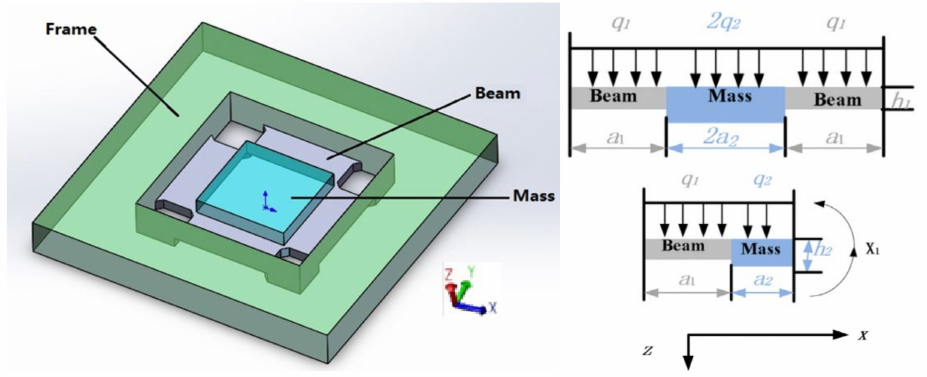
Figure 5. High-G micromechanical systems (MEMS) accelerometer (HGMA) structure schematic and size.